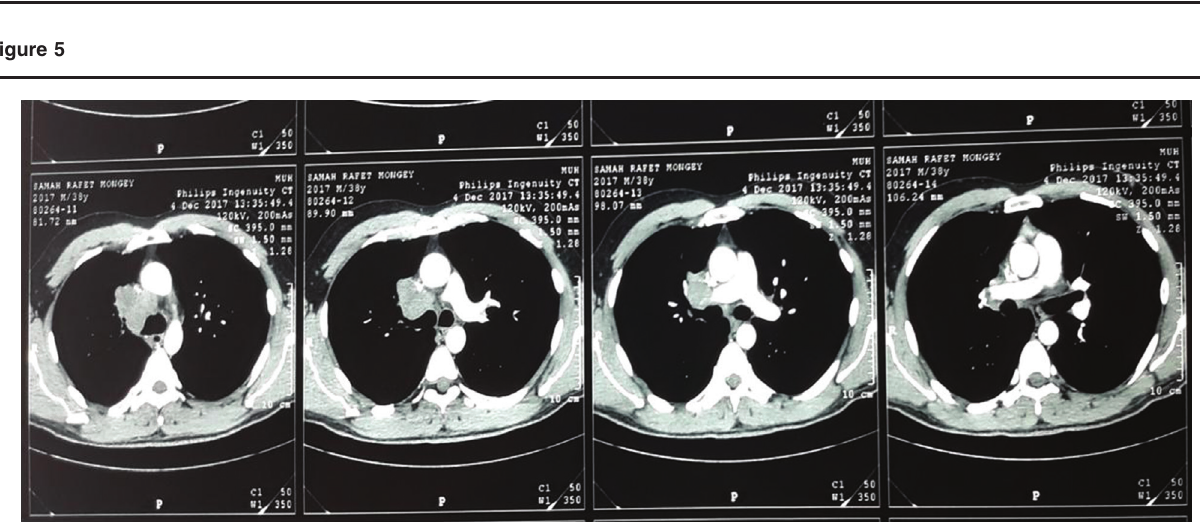
Right paratracheal mass approached by mediastinoscopy and diagnosed as Hodgkin